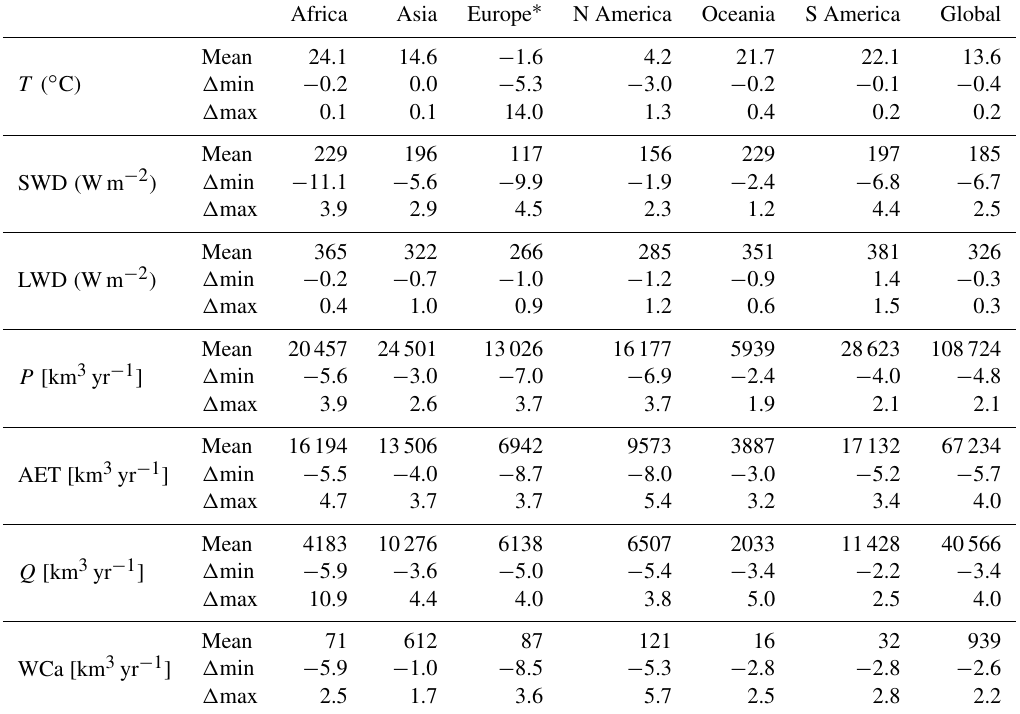
Table 3. Continental climate forcing variables ( T , SWD, LWD, P ) and water balance components (AET, Q , WCa). Ensemble mean and min/max deviation from mean (in percent, also for T ) over all four homogenous forcing variants (GSWP3, PGFv2.1, WFD, WFDEI_hom), for six continental regions, and the global total for the time period 1971–2000.